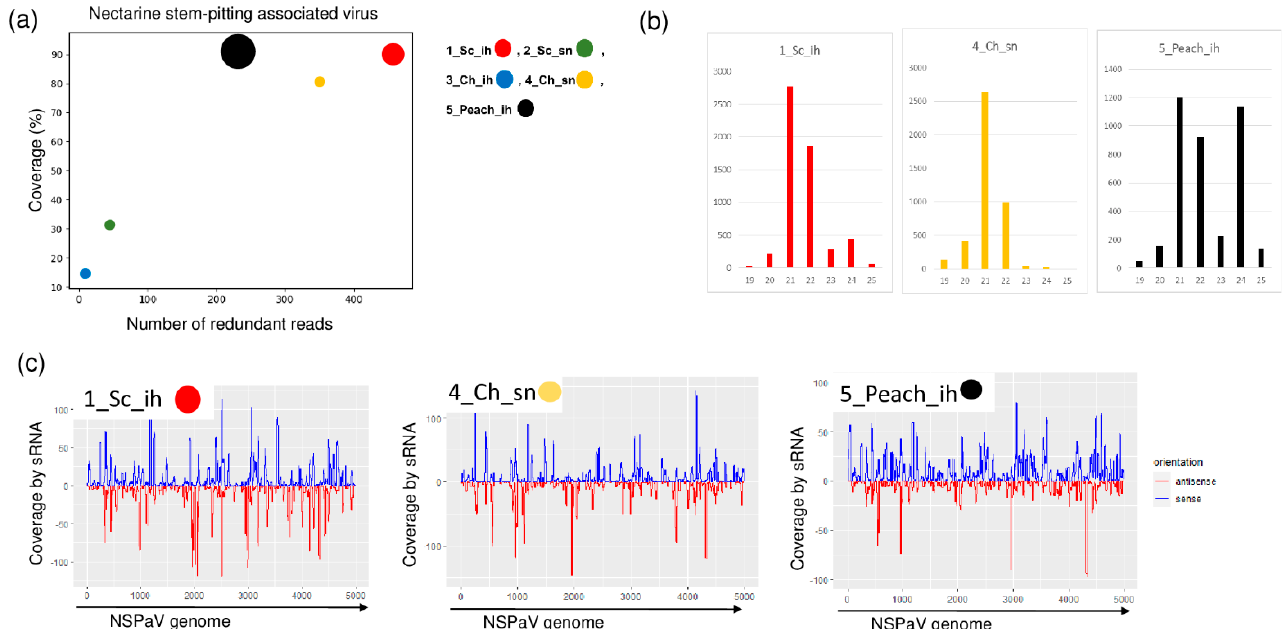
Figure 3. The result of the sRNA HTS and its validation for NSPaV in the five sRNA libraries. ( a ) The graphic representation of the result of the bioinformatics analysis of sRNA HTS. The coverage of the NSPaV genome ( y -axis) together with the number of RPM (number of NSPaV-specific non- redundant reads in 1 million sequenced reads on the x -axis) was plotted as a circle whose diameter is proportional to the number of contigs. Different colors were used for the five libraries, as indicated. ( b ) The size class distribution of the NSPaV-derived reads in 1_Sc_ih, 4_Ch_sn and 5_Peach_ih libraries. ( c ) NSPaV-derived reads in 1_Sc_ih, 4_Ch_sn and 5_Peach_ih libraries are shown as they mapped to the NSPaV genome, indicating their sense and antisense origin (Sc: Springcrest; Ch: Cresthaven; ih: isolator house; sn: stock nursery).